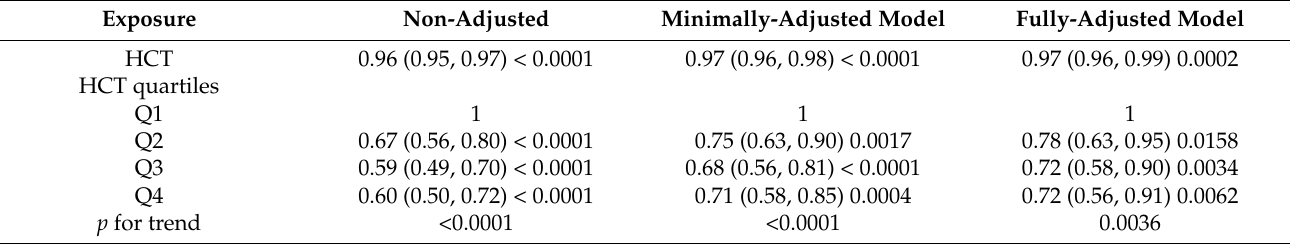
Table 2. Univariate and multivariate results by cox regression (N = 2589).